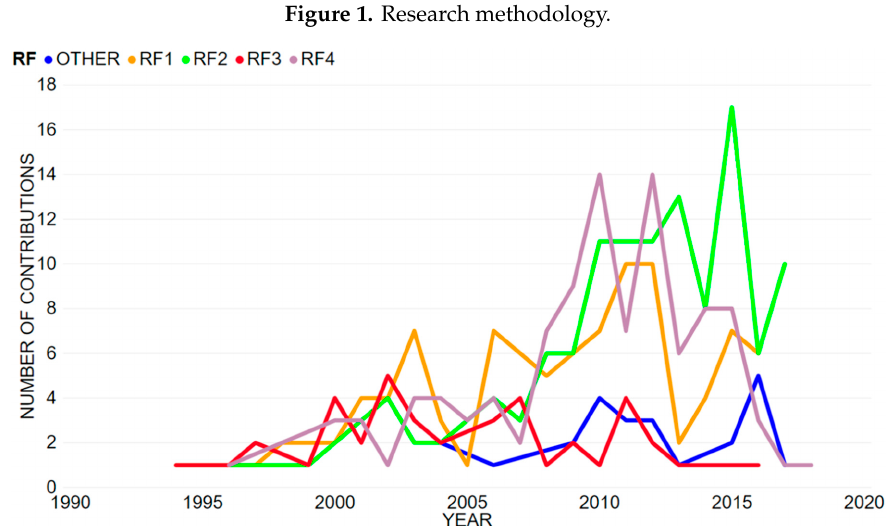
Figure 1. Research methodology. Machines 2020 , 8 , x FOR PEER REVIEW